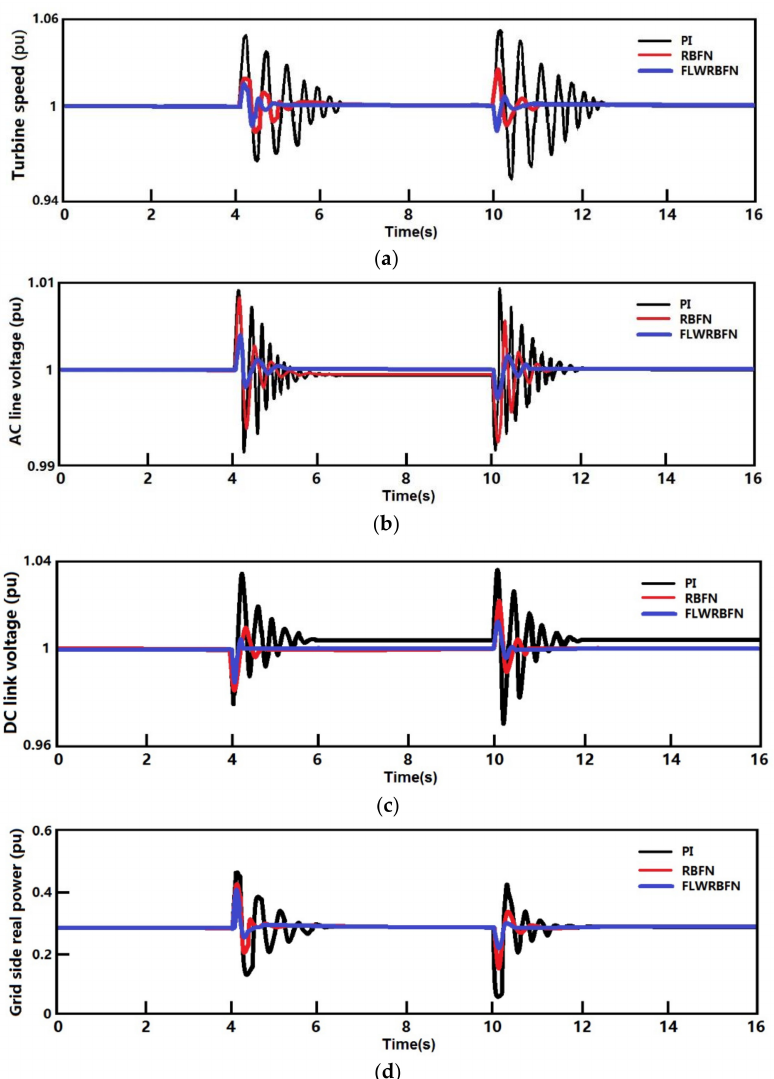
Figure 3. The dynamic simulation results of the studied system under load change: ( a ) Turbine speed; ( b ) AC line voltage; ( c ) DC link voltage; ( d ) Grid side real power.